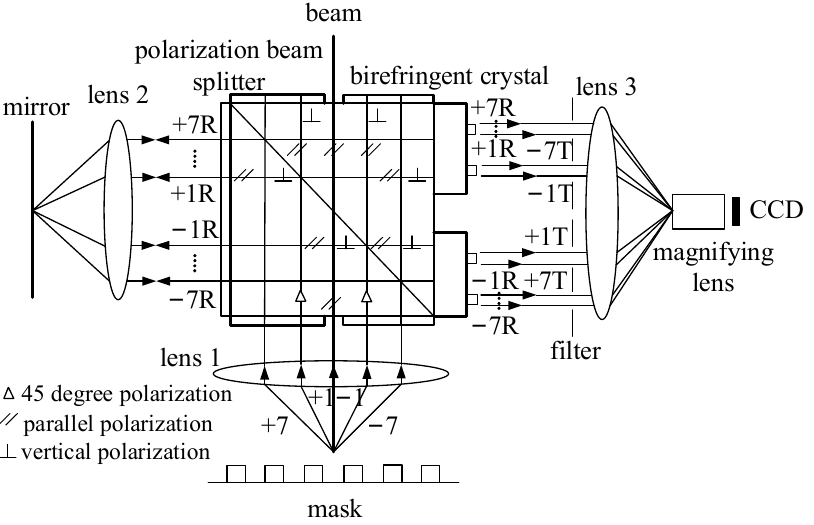
Figure 10. Schematic of self-coherent Moiré grating fringe alignment